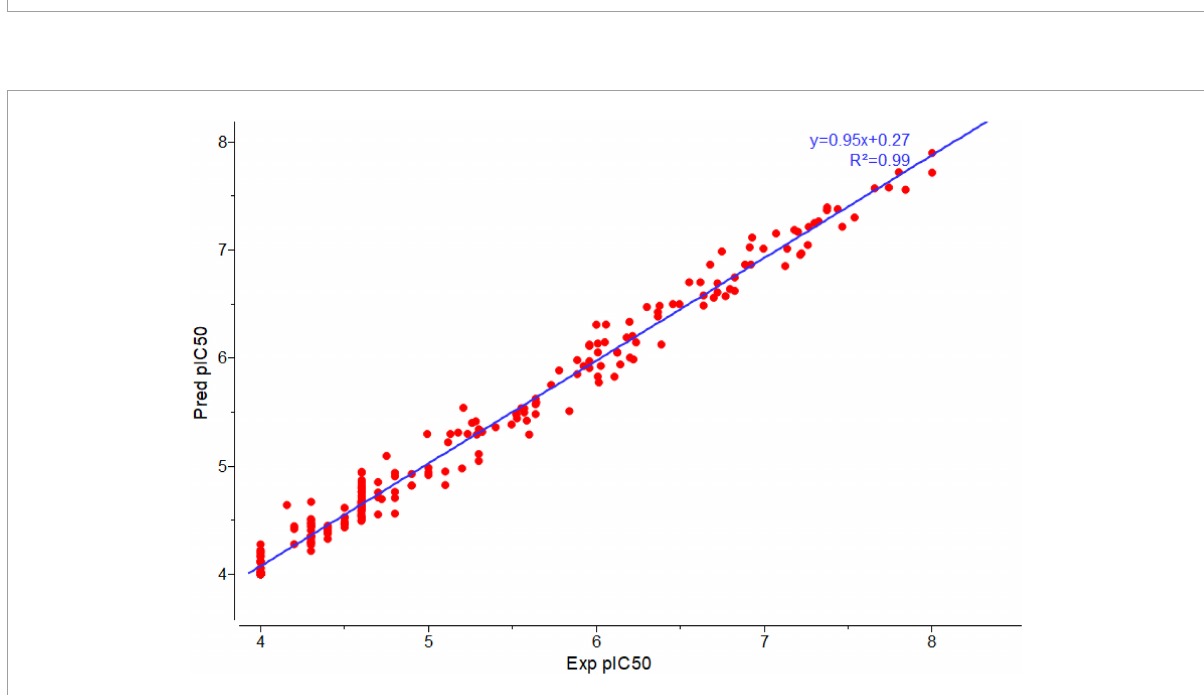
FIGURE4 Plot correlation between experimental and predicted pIC50 by using Random Forest-regressor. Adopted from